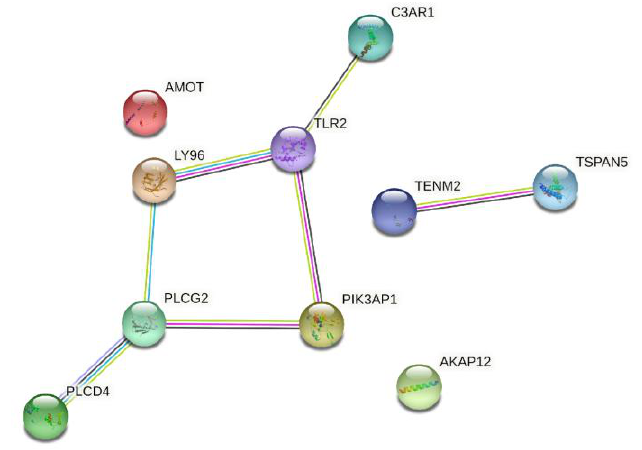
Figure 4. Overall protein–protein interaction network of top 10 genes with the highest connectiv- ity. Table 1. Top 10 hub genes with higher degrees of connectivity .